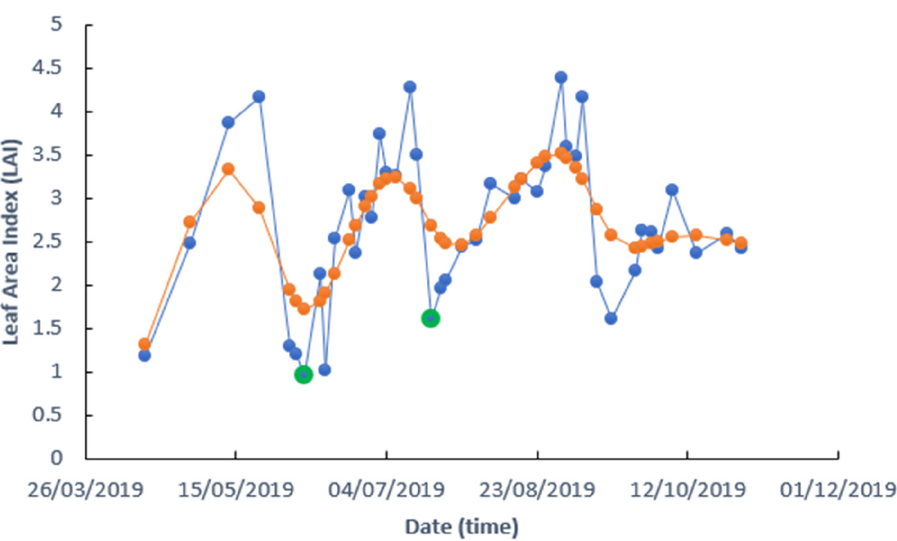
Figure 9. Observed signal (blue) and smoothed (orange) LAI time series of an IPG pixel showing two mowing events (green